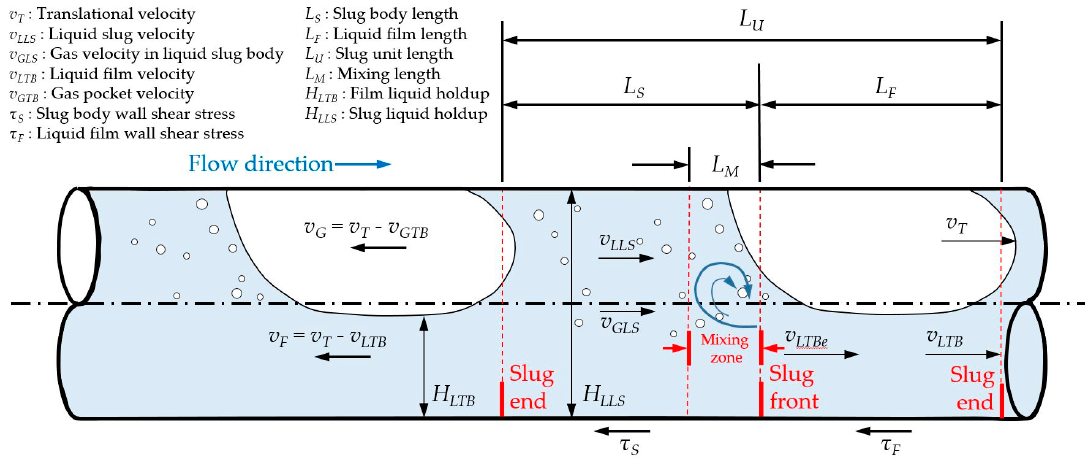
Figure 1. Illustration of slug flow.